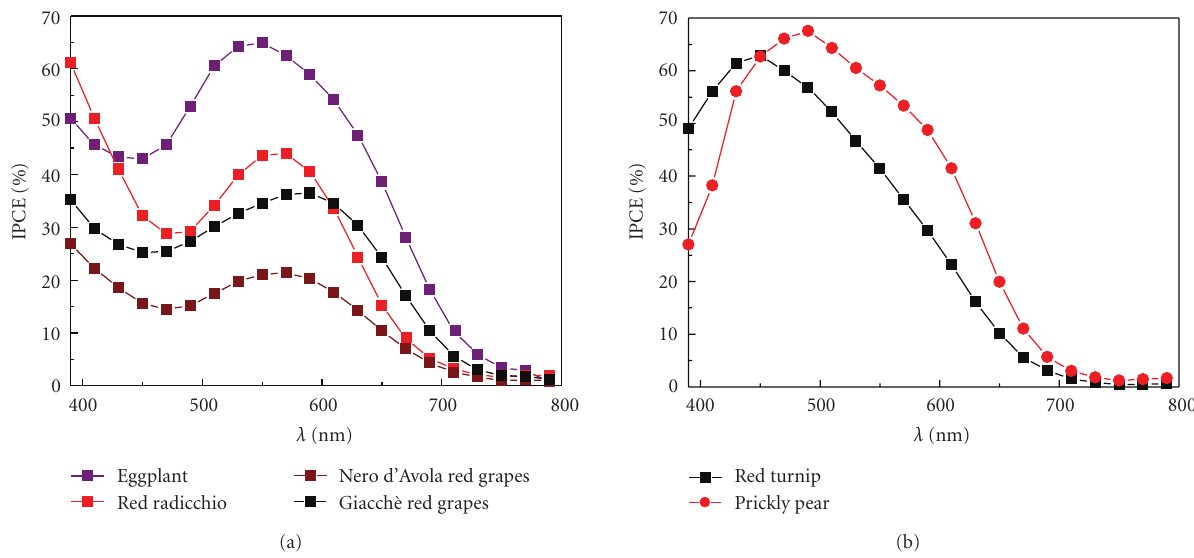
Figure 4: Photoaction spectra on transparent TiO 2 of (a) anthocyanine raw extracts from eggplant (purple), red radicchio (red), Giacch`e red grapes (black), and Nero d’Avola red grapes (brown); (b) betalains from red turnip (black) and wild prickly pear (red). LiI/I 2 0.5 M/0.05M in ACN was used as a redox electrolyte.